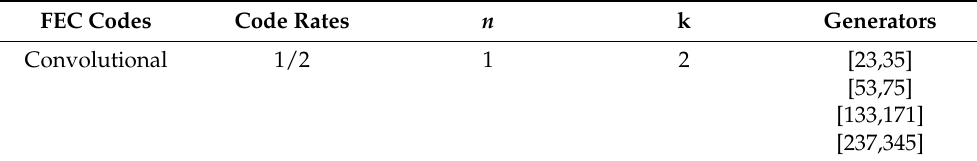
Table 1. Convolutional codes parameter